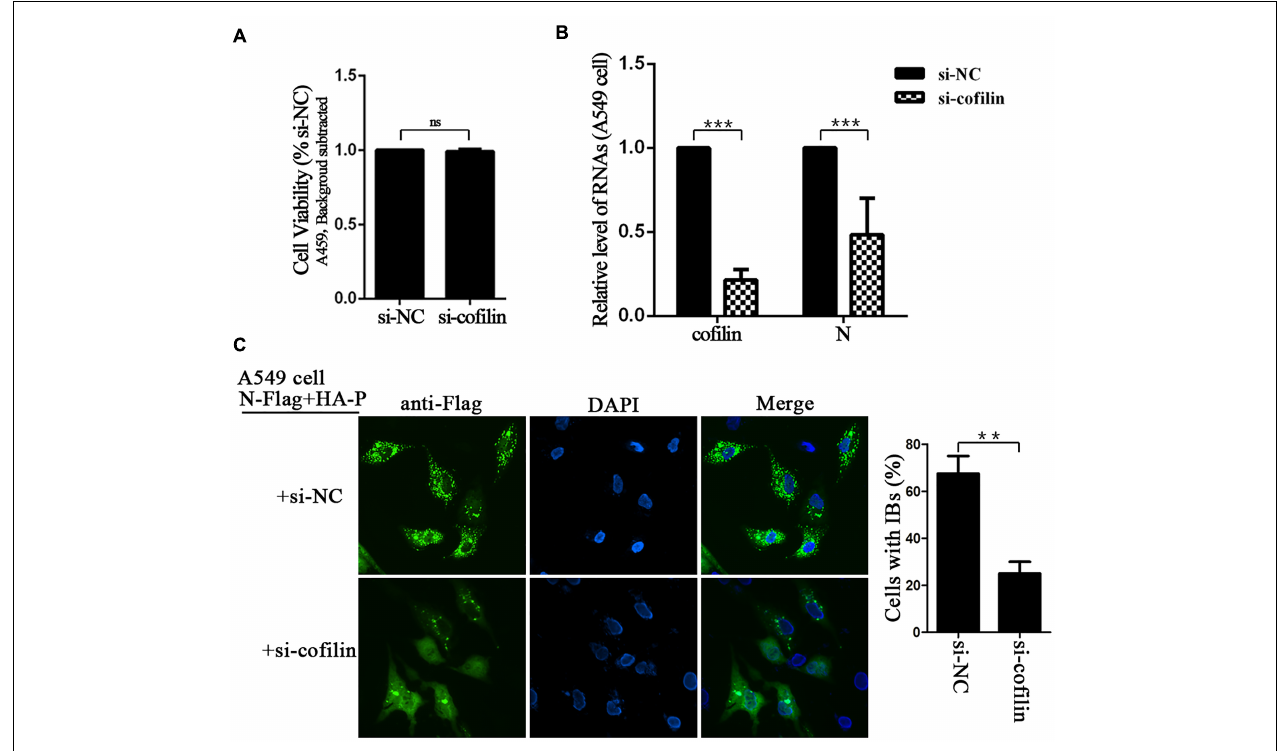
FIGURE 4 | Depletion of cofilin affects IBs formation and RNA synthesis in A549 cells. (A) A549 cells transfected with si-NC or si-cofilin for 24 h, and the cell viability was examined by CCK8 assay as the manufacture’s instruction. The viability of cell was not significantly influenced by cofilin depletion. Data are means ± SD from three experiments. Student’s test: ns, non-significant. (B) A549 cells were infected with wild type HPIV3 at an MOI of 1 for 6 h, then si-NC or si-cofilin were transfected. At 24 h posttransfection, the cells were collected and real-time PCR was performed to detect RNAs of cofilin and N. Cellular β -actin mRNA was used as the control. Samples were examined in triplicate, and data are means ± SD from three experiments. Student’s test: ∗∗∗ p < 0.001. (C) A549 cells were transfected with the plasmids encoding N-Flag and HA-P, as well as si-NC or si-cofilin. At 24 h posttransfection, the cells were fixed, N-Flag was immunostained to visualize IBs and nuclei were counterstained with DAPI. The percentage of cells containing IBs were quantified, data are means ± SD from three experiments. Student’s test: ∗∗ p < 0.05.